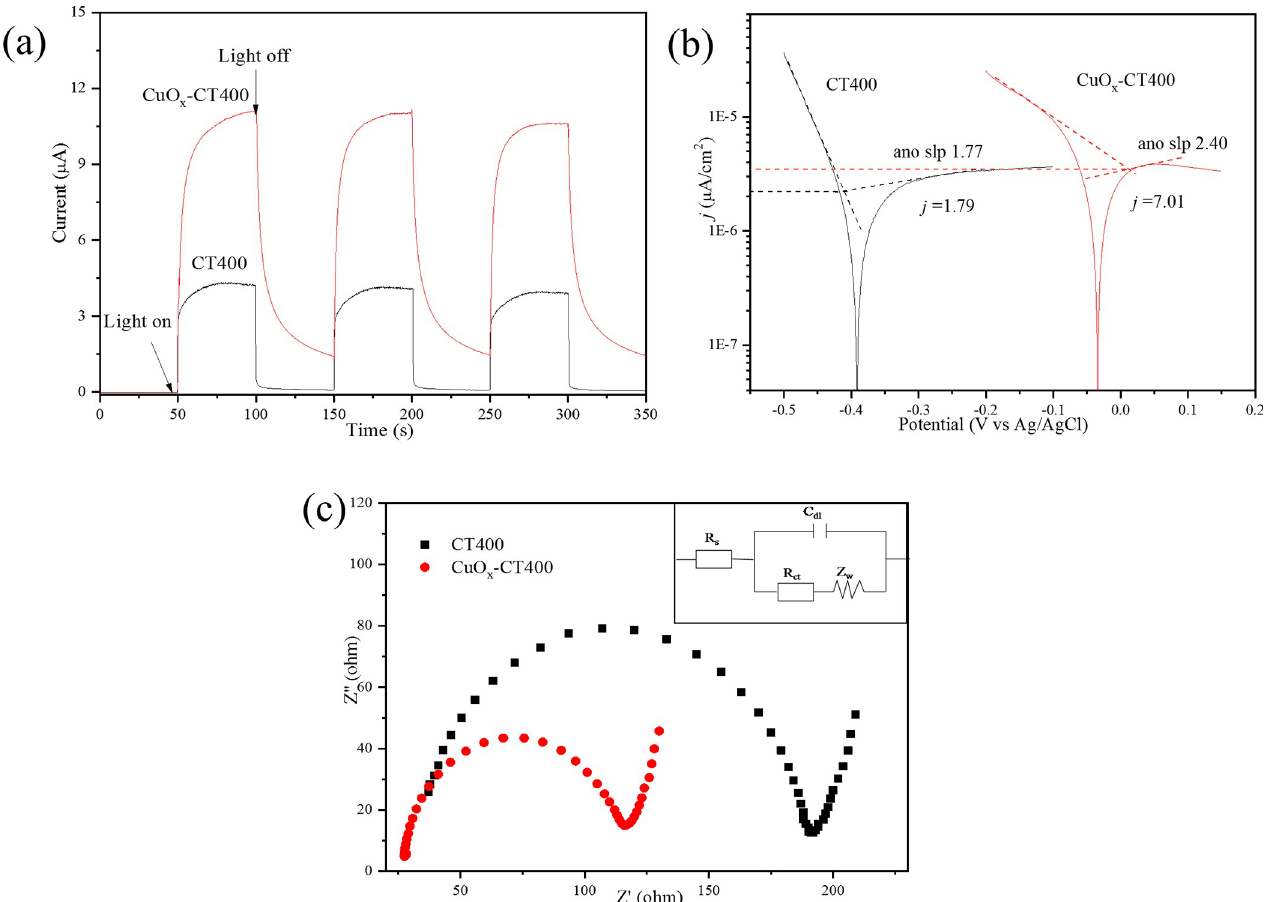
Fig 9. Photoelectrochemical properties of CT400 and CuO x -CT400 catalyst with i-t spectra (a), Tafel spectra (b), and Nyqusit spectra (c). The inset is the equivalent circuit model.